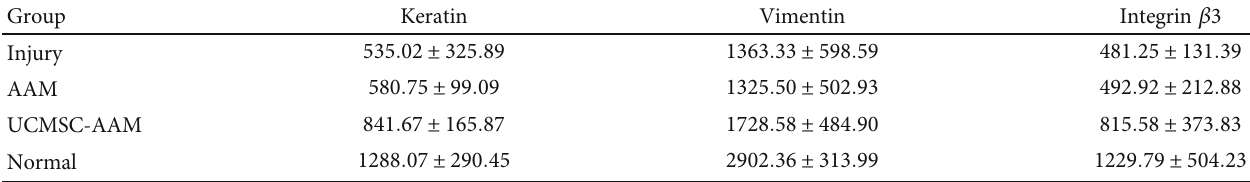
Table 3: IOD value of endometrial cell-speci fi c proteins and endometrial receptivity protein in the groups ( (cid:1) X ± S ). Group Keratin